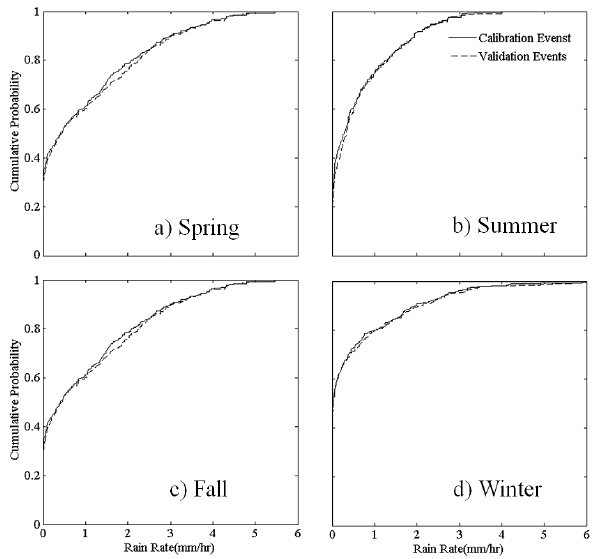
Figure 2. Cumulative probability of radar rainfall rain rates in the calibration and validation events selected for each